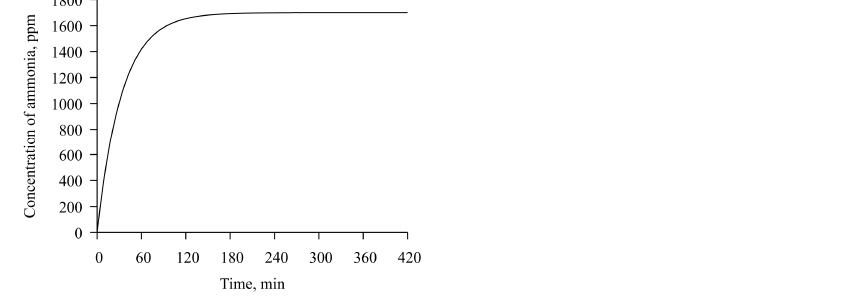
Figure 8. Computed time dependencies of ammonia concentration in air, by weight, in a gas chamber.